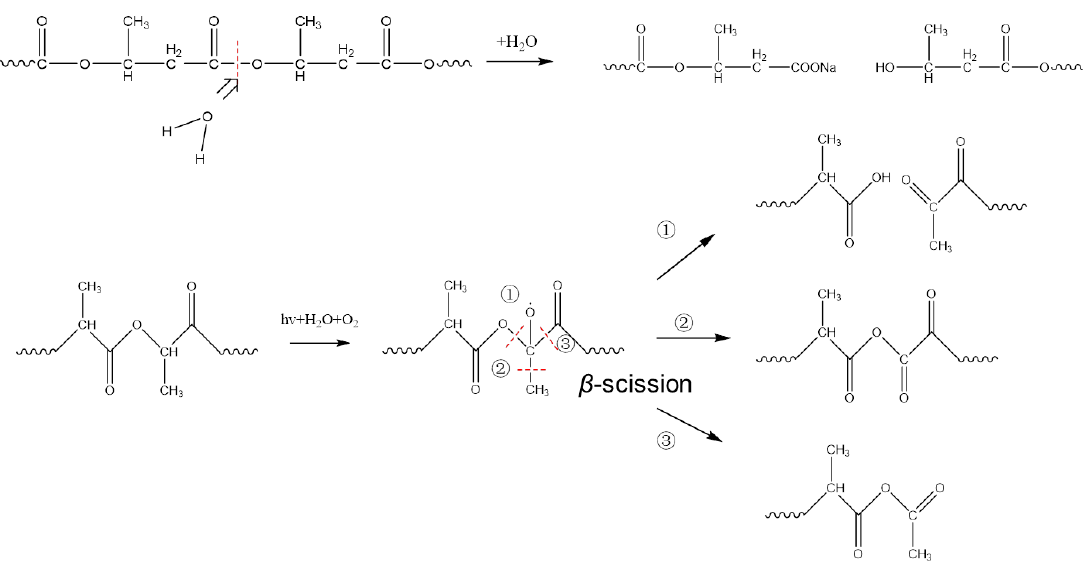
Figure 8. Digital microscopic images of ( A ) PLA/PHB woven fabrics, ( B ) multi-filament yarns used in fabrics after 21 days immersion in seawater under UV + Air condition.